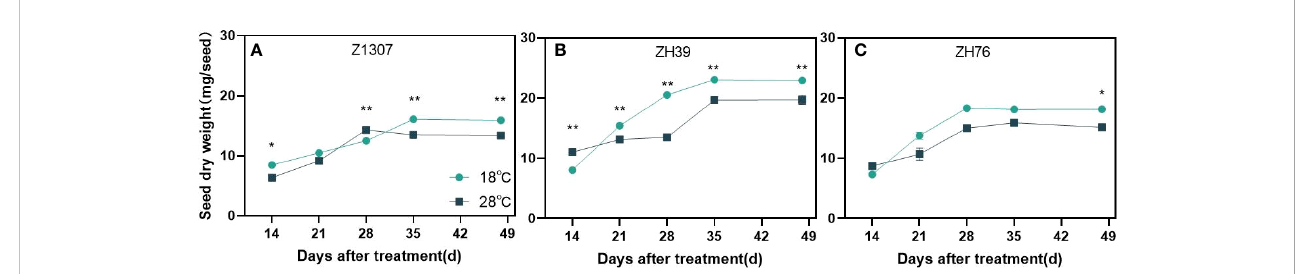
FIGURE 3 Dynamic changes of soybean seed weight under different night temperatures. The dark blue/black blue line indicates the 18 ℃ /28 ℃ treatment. The broken lines respect the dynamic changes of soybean seed weight of the variety Z1307 (A) , ZH39 (B) and ZH76 (C) under different night temperatures. Values shown are means ± SE from three biological replicates. (*, P < 0.05;**, P < 0.01).